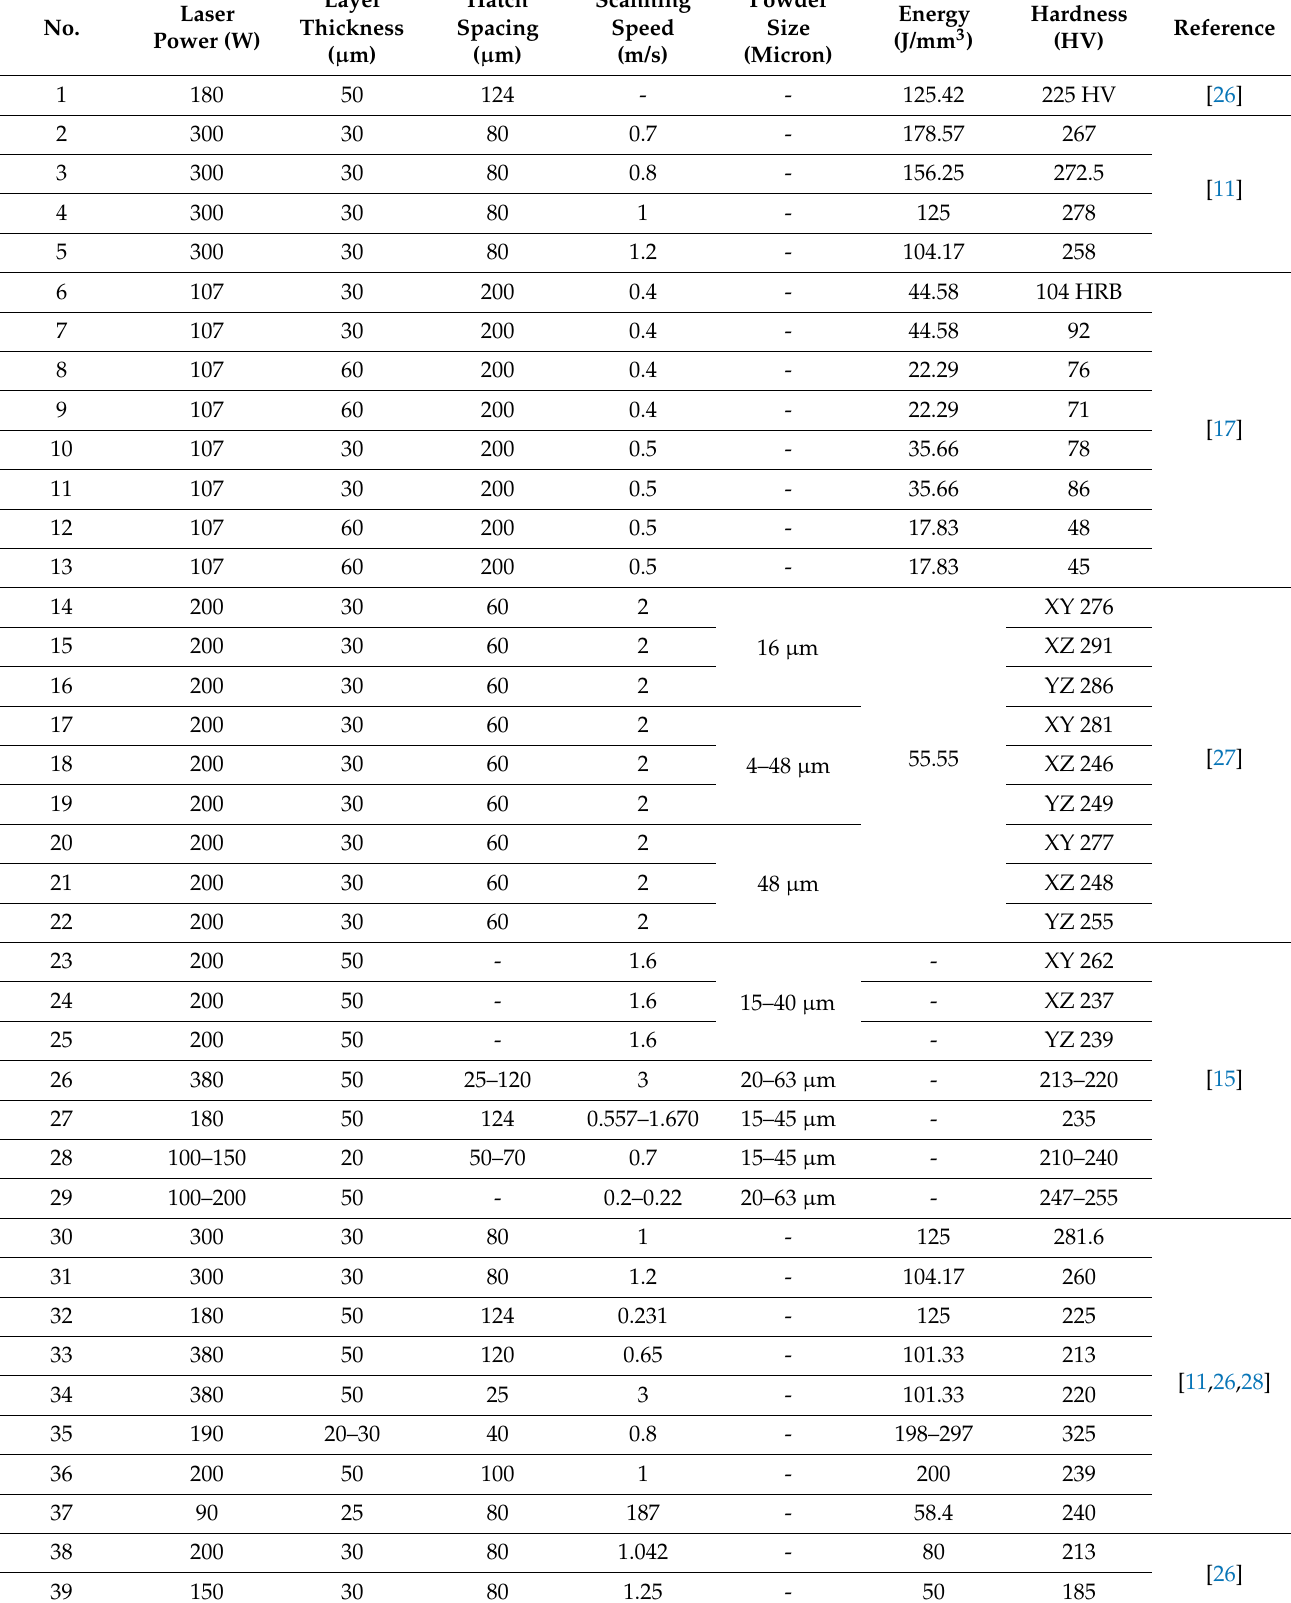
Table 2. Effect of different process parameters on